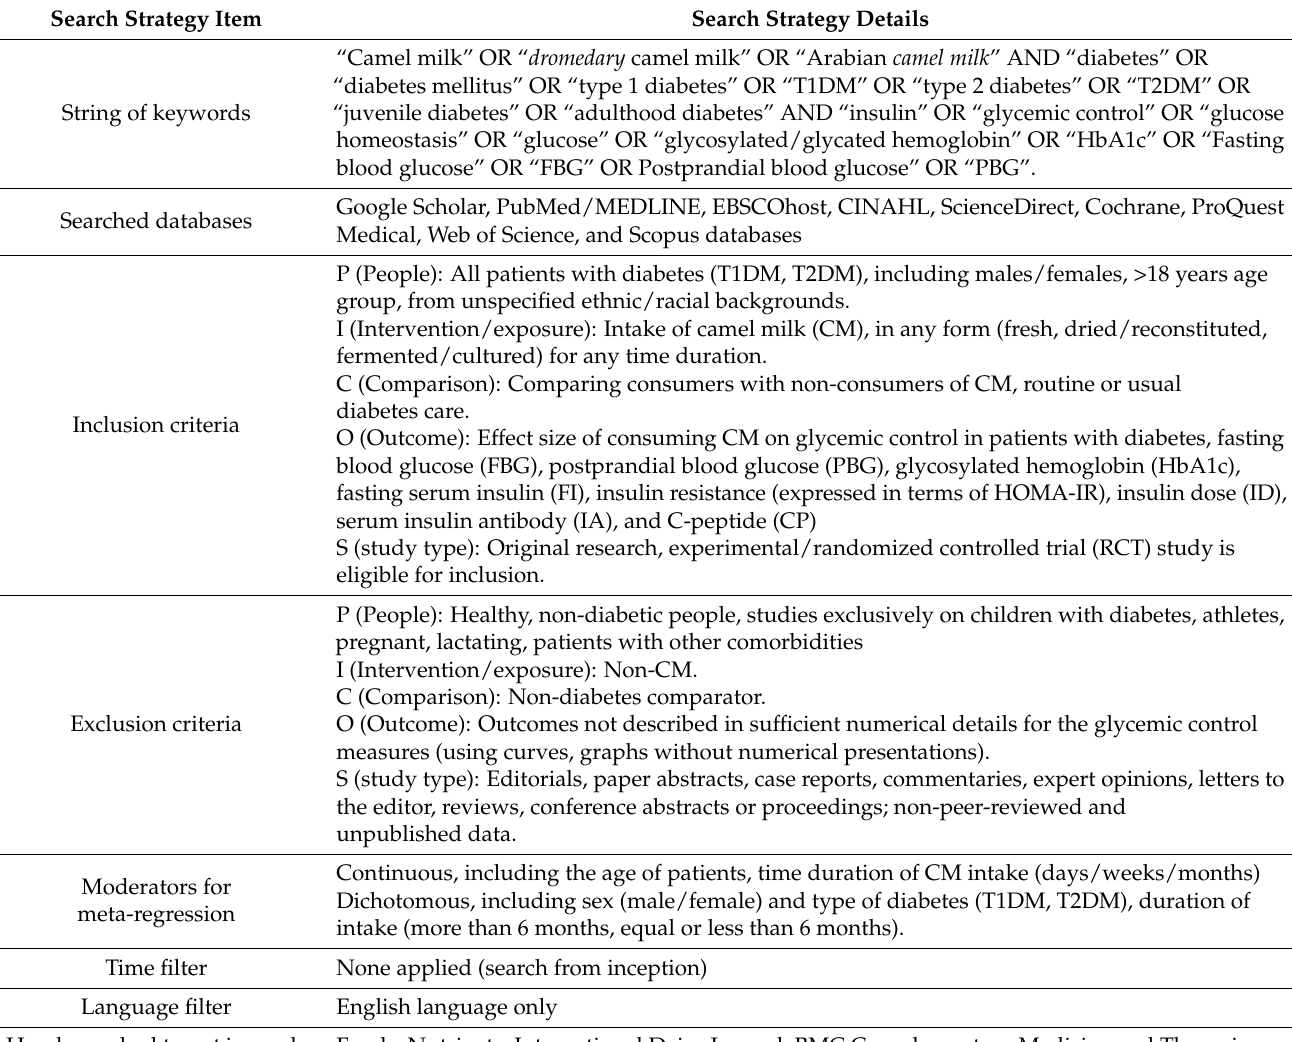
Table 1. A summary of the search strategy adopted in the present systematic review and meta-analysis assessing the effects of camel milk (CM) intake on glycemic control among patients with